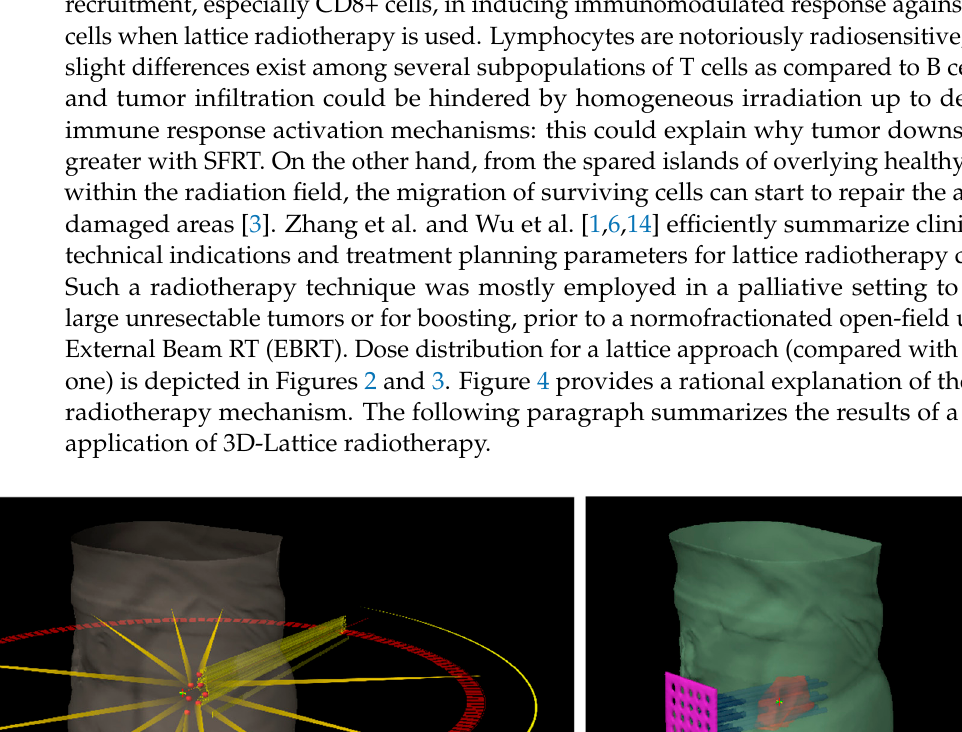
Figure 3. Dose distribution in the axial plane ( left ), the coronal plane ( middle ), and the sagittal plane ( right ). Figure 4. The hypothesis to explain lattice radiotherapy mechanism: pink line delineates global tumor volume, the yellow line shows the necrotic core, and red spheres represent high dose regions and are approximately located at the boundary between the necrotic and normoxic areas (hypoxigenated interface) to radially elicit the bystander effect (blue arrows), accurately avoiding high dose delivery in the green strip due to the hazardous closeness of bowel (Organ At Risk: OAR).